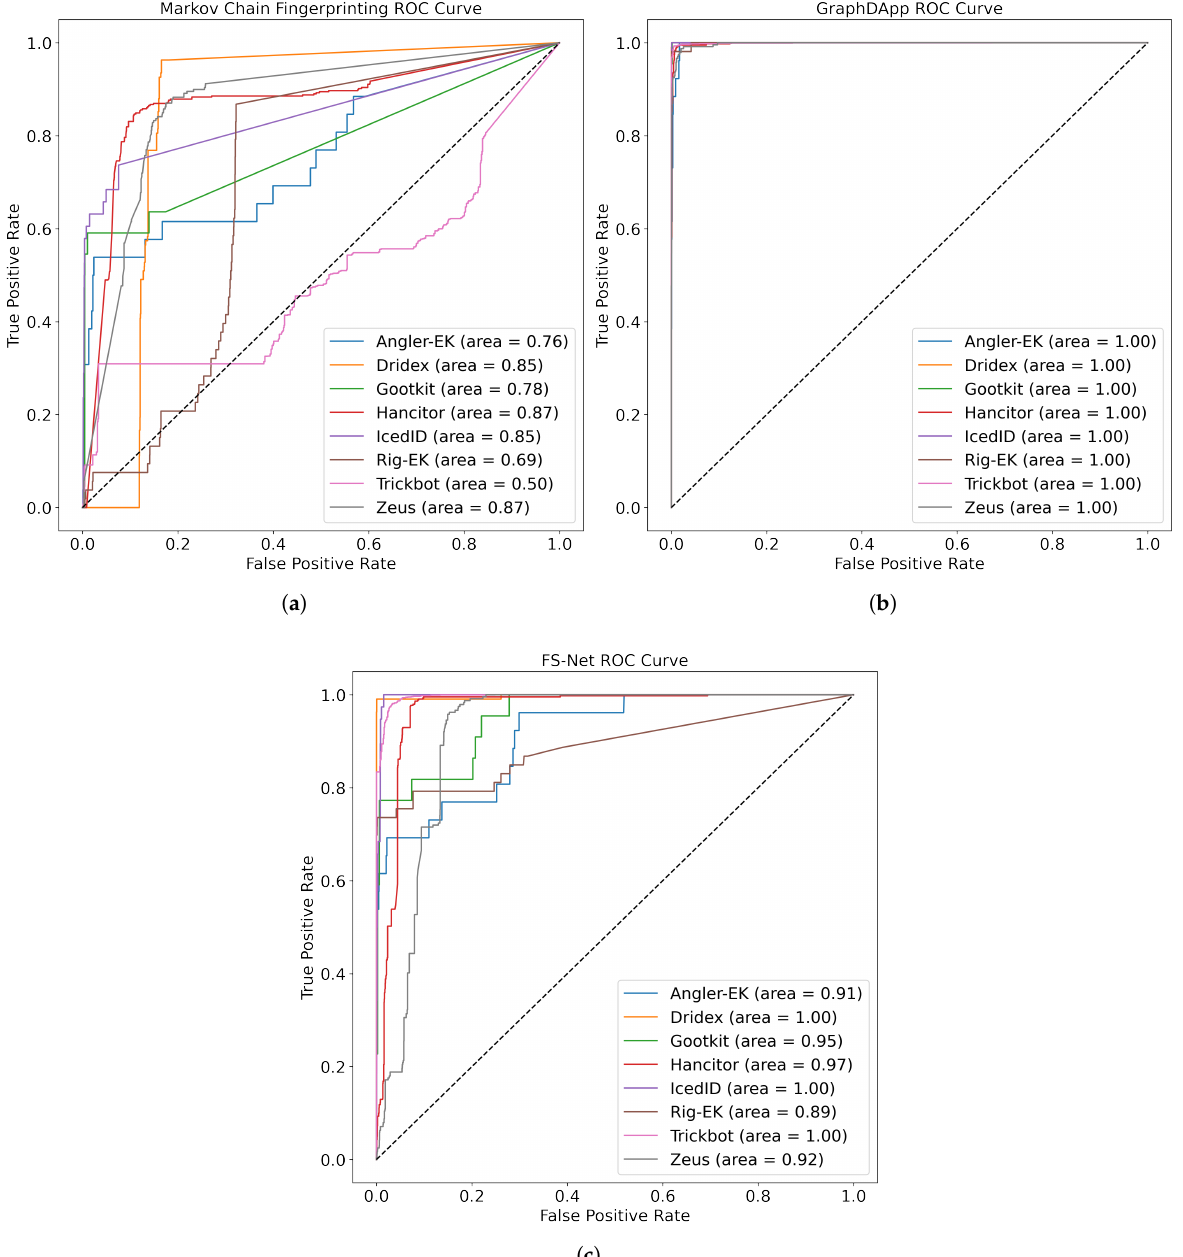
Figure 6. ROC curves using ( a ) Markov chain fingerprinting with maximum likelihood classifier, ( b ) traffic interaction graph with fully connected layer classifier (GraphDApp), and ( c ) embedding vector with